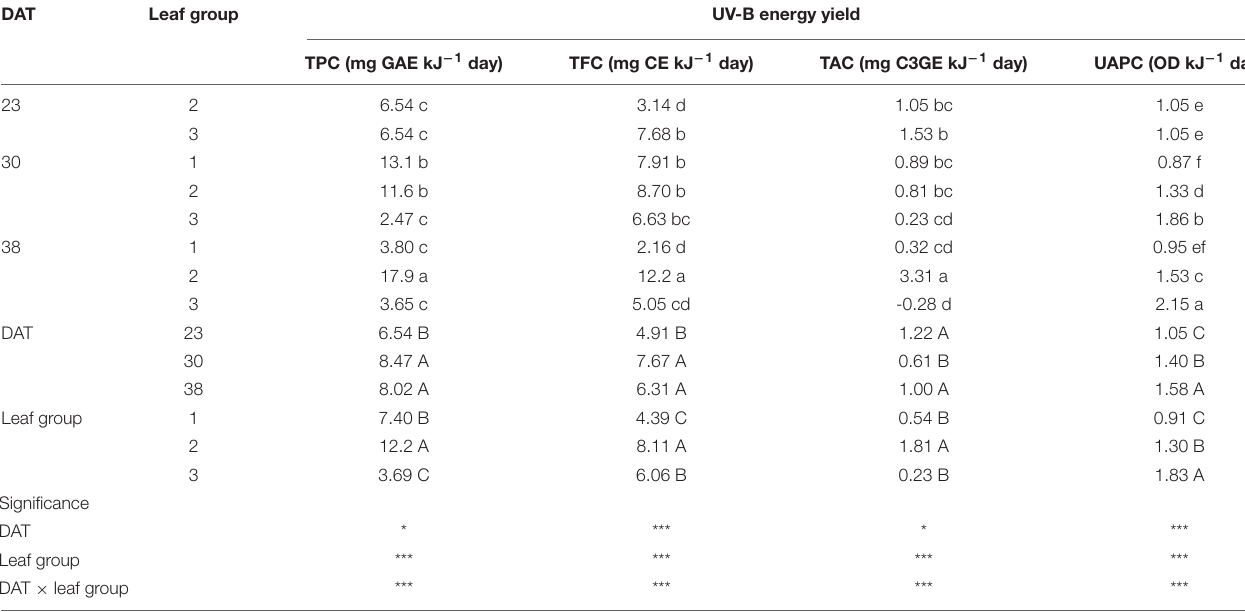
TABLE 2 | UV-B energy yields for phenolic content per leaf of kale plants with leaf group at 23, 30, and 38 days after transplanting (DAT) referring to Eq. 2 and Table 1 . DAT Leaf